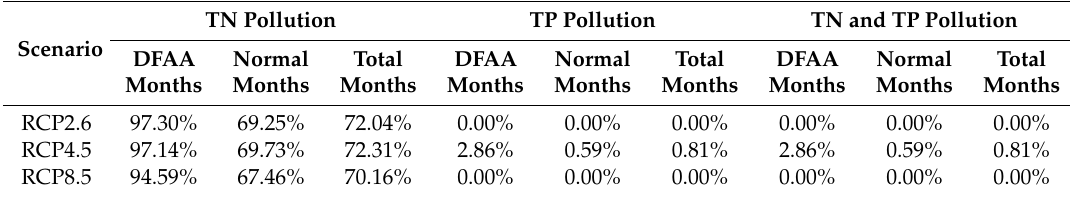
Table 6. The incidence of water pollution (%) in Class IV under different